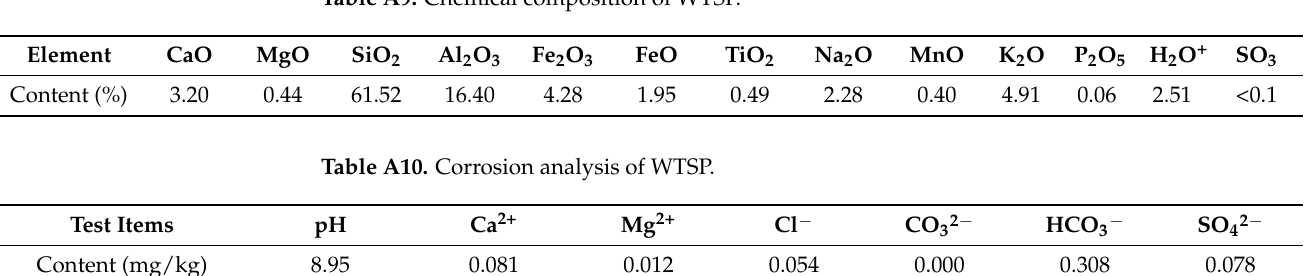
Table A9. Chemical composition of WTSP.